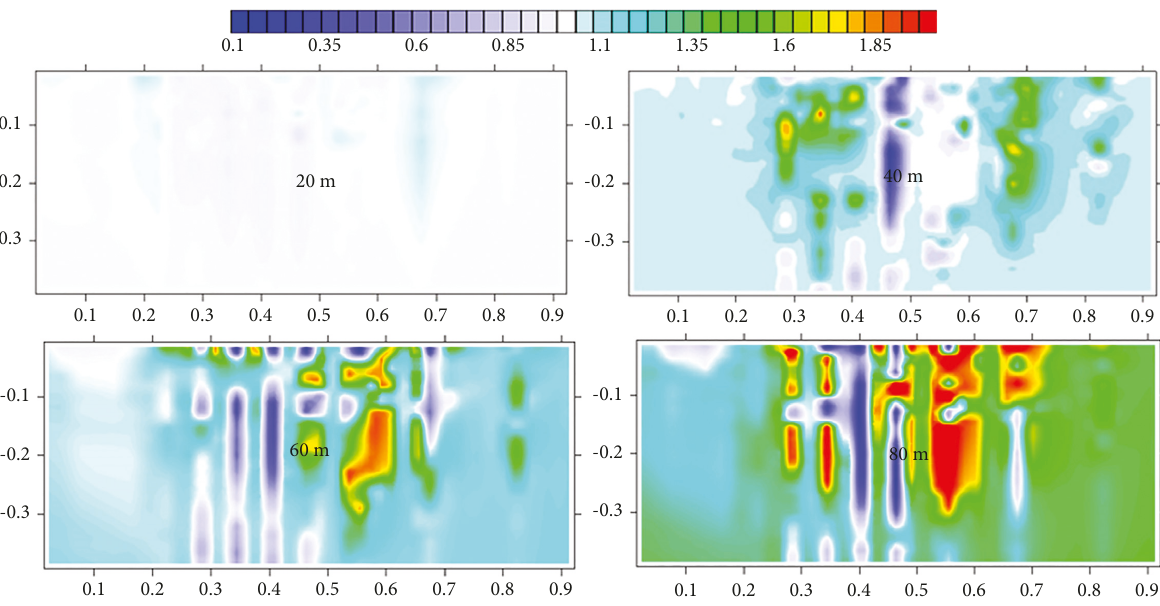
Figure 14: The resistivity section ratio chart in the x - z surface at 40cm above the coal seam ( y